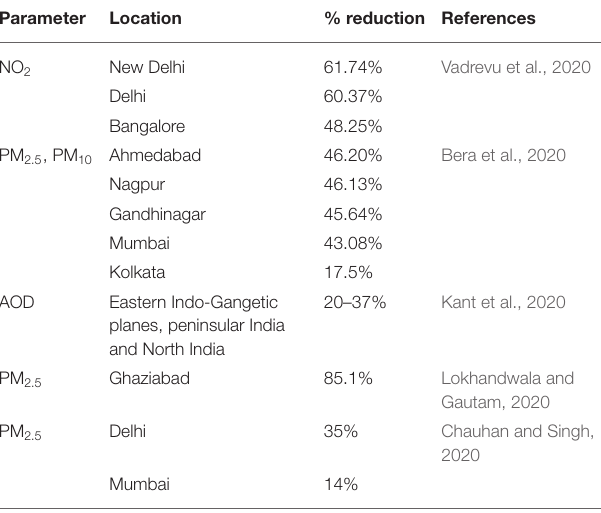
TABLE 2 | Percent reduction in air pollutants for Indian cities during COVID-19